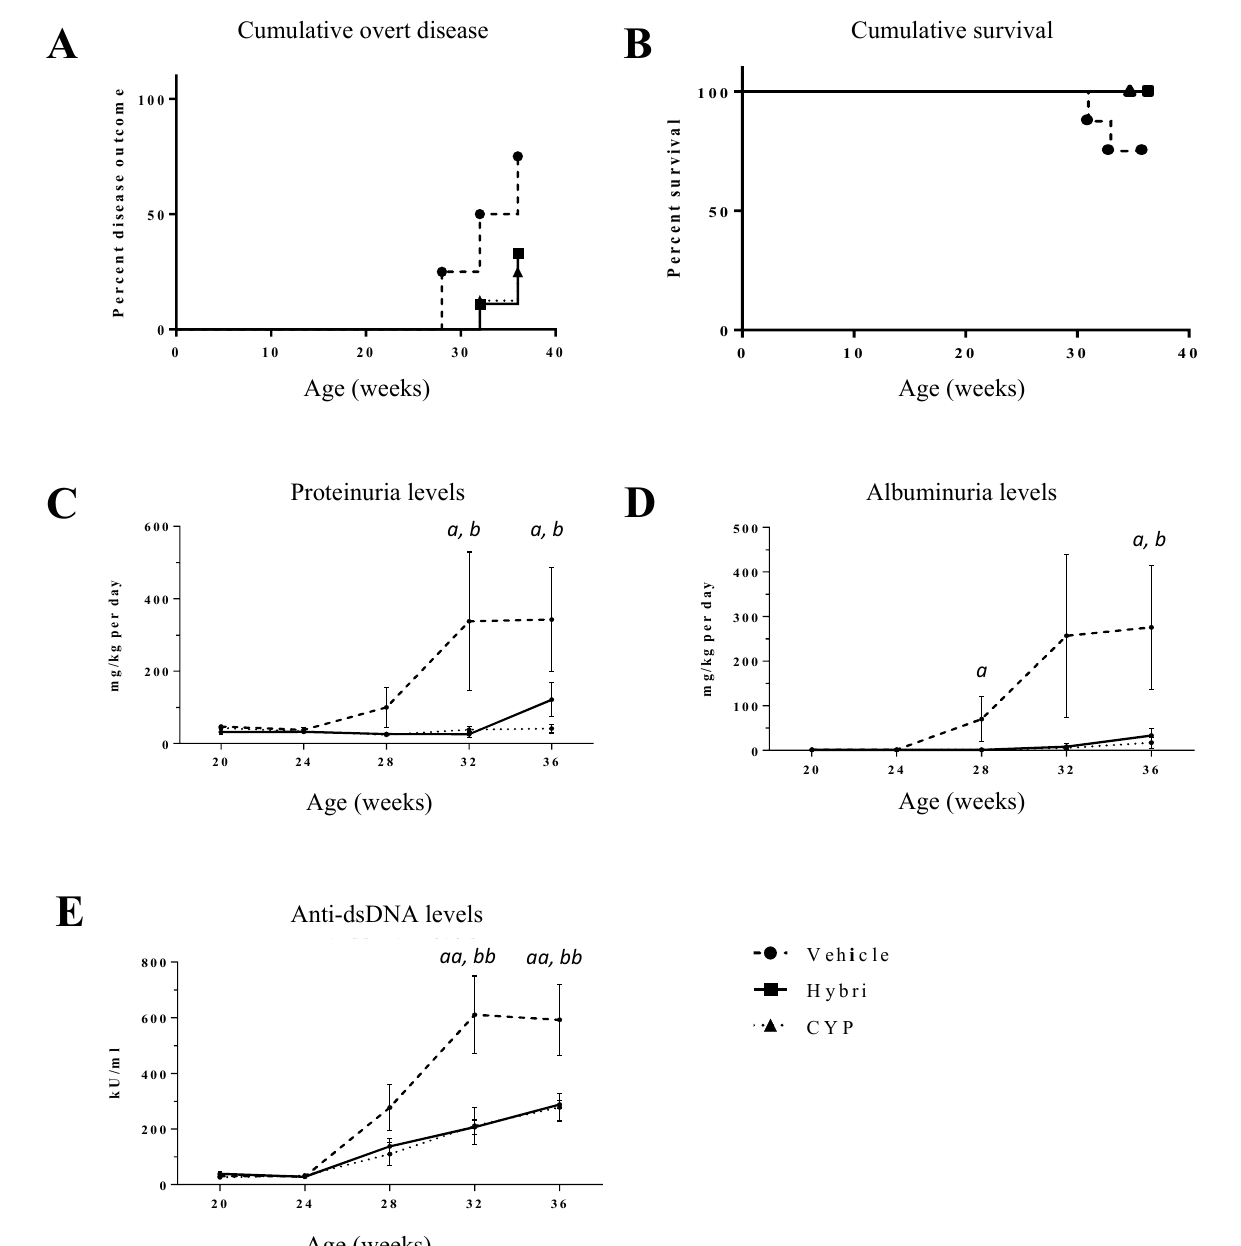
Figure 1. Hybri administration delayed the onset of overt disease, improved the survival curve, and preserved the functional renal parameters similar to those of mice treated with CYP throughout the study in the NZBWF1 mice model. ( A ) Cumulative overt disease for the NZBWF1 until the endpoint of the study at 36 weeks of mice age. Disease outcome was considered when proteinuria levels exceeded 3 mg per day. ( B ) Kaplan–Meier survival curve for the NZBWF1 model. Log Rank Mantel–Cox test revealed non-significant differences between groups neither for cumulative overt disease nor cumulative survival. Proteinuria ( C ) and albuminuria ( D ) values throughout the study are expressed in mg normalized per body weight per day. Serum anti-dsDNA ( E ) levels throughout the study are expressed in KU/mL. Vehicle group: n = 8; Hybri group: n = 9; CYP group: n = 8. Data are expressed as mean values ± S.E.M. Hybri vs. Vehicle: a = p < 0.05, aa = p < 0.01; CYP vs. Vehicle: b = p < 0.05, bb = p < 0.01.